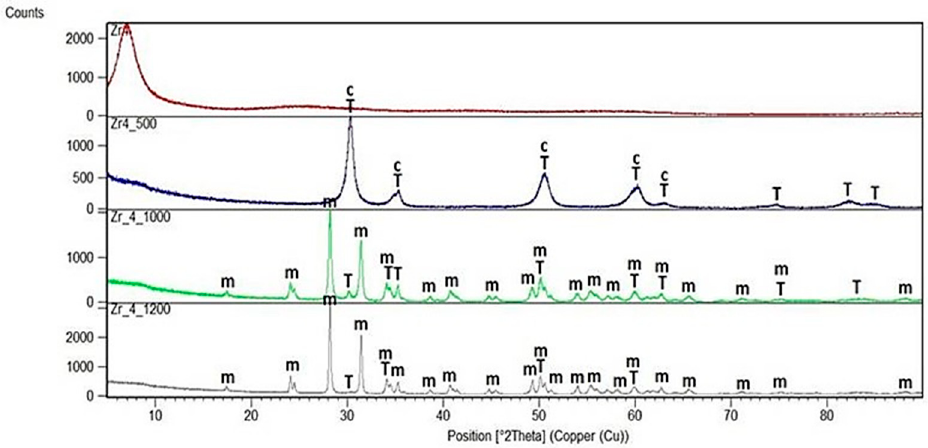
Figure 1. X-Ray diffraction pattern of pure ZrO 2 gel (4% weight ZrO 2 ) annealed at 500 °C, 1000 °C and 1200 °C in the air (m—monoclinic ZrO 2 , T—tetragonal ZrO 2 , c—cubic ZrO 2 ).